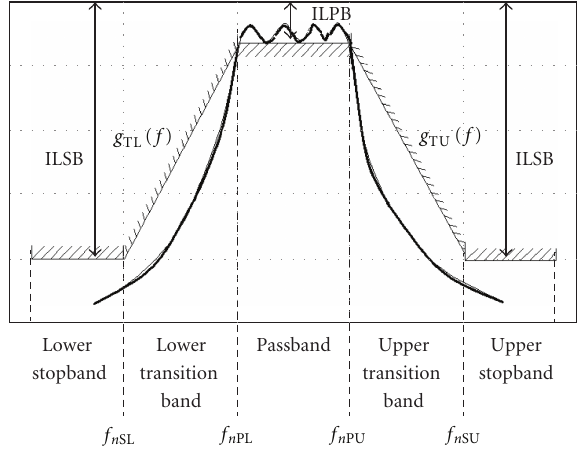
Figure 3: Specified frequency response of the bandpass